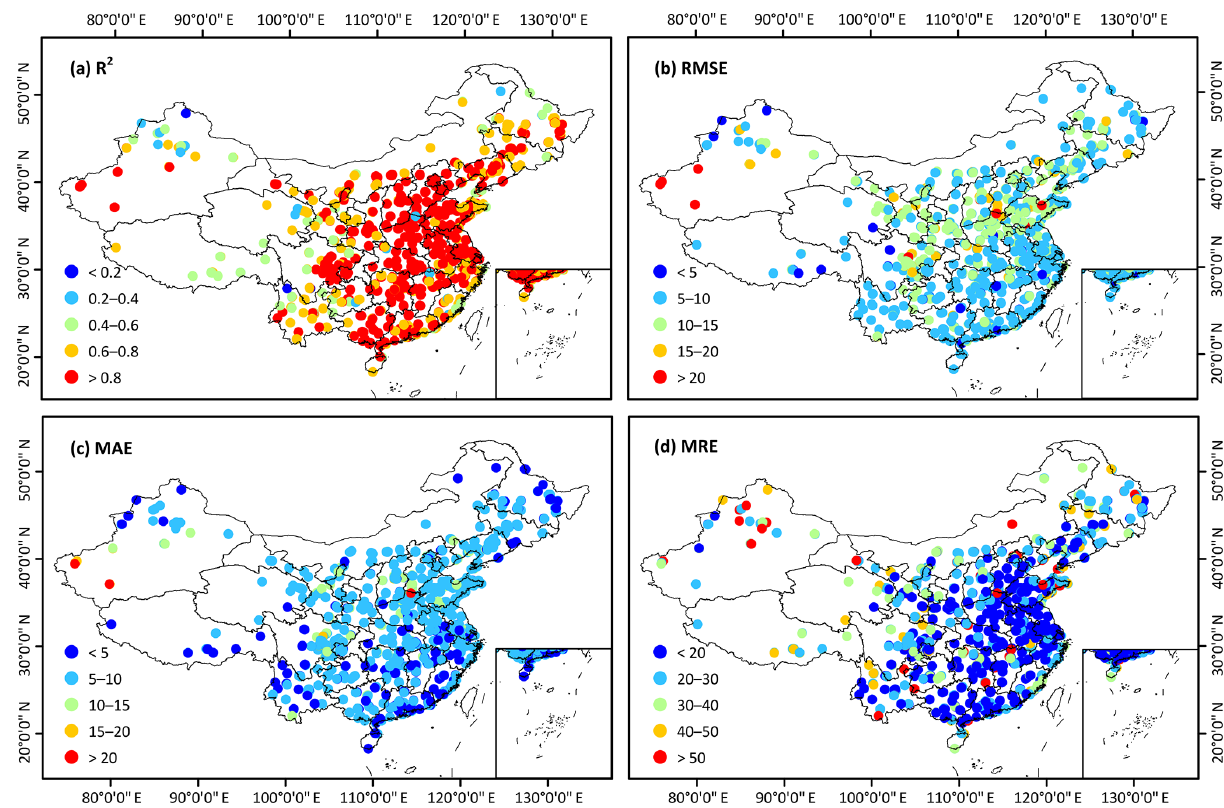
Figure 7. Spatial distributions of the site-scale performance of the STET model for (a) the sample-based cross-validation coefficient of determination ( R 2 ), (b) the root-mean-square error (RMSE), (c) the mean absolute error (MAE) and (d) the mean relative error (MRE) in 2018 across China.